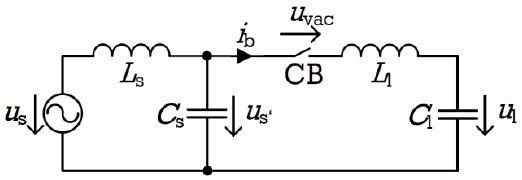
Figure 6. Circuit diagram for single phase filter current interruption.